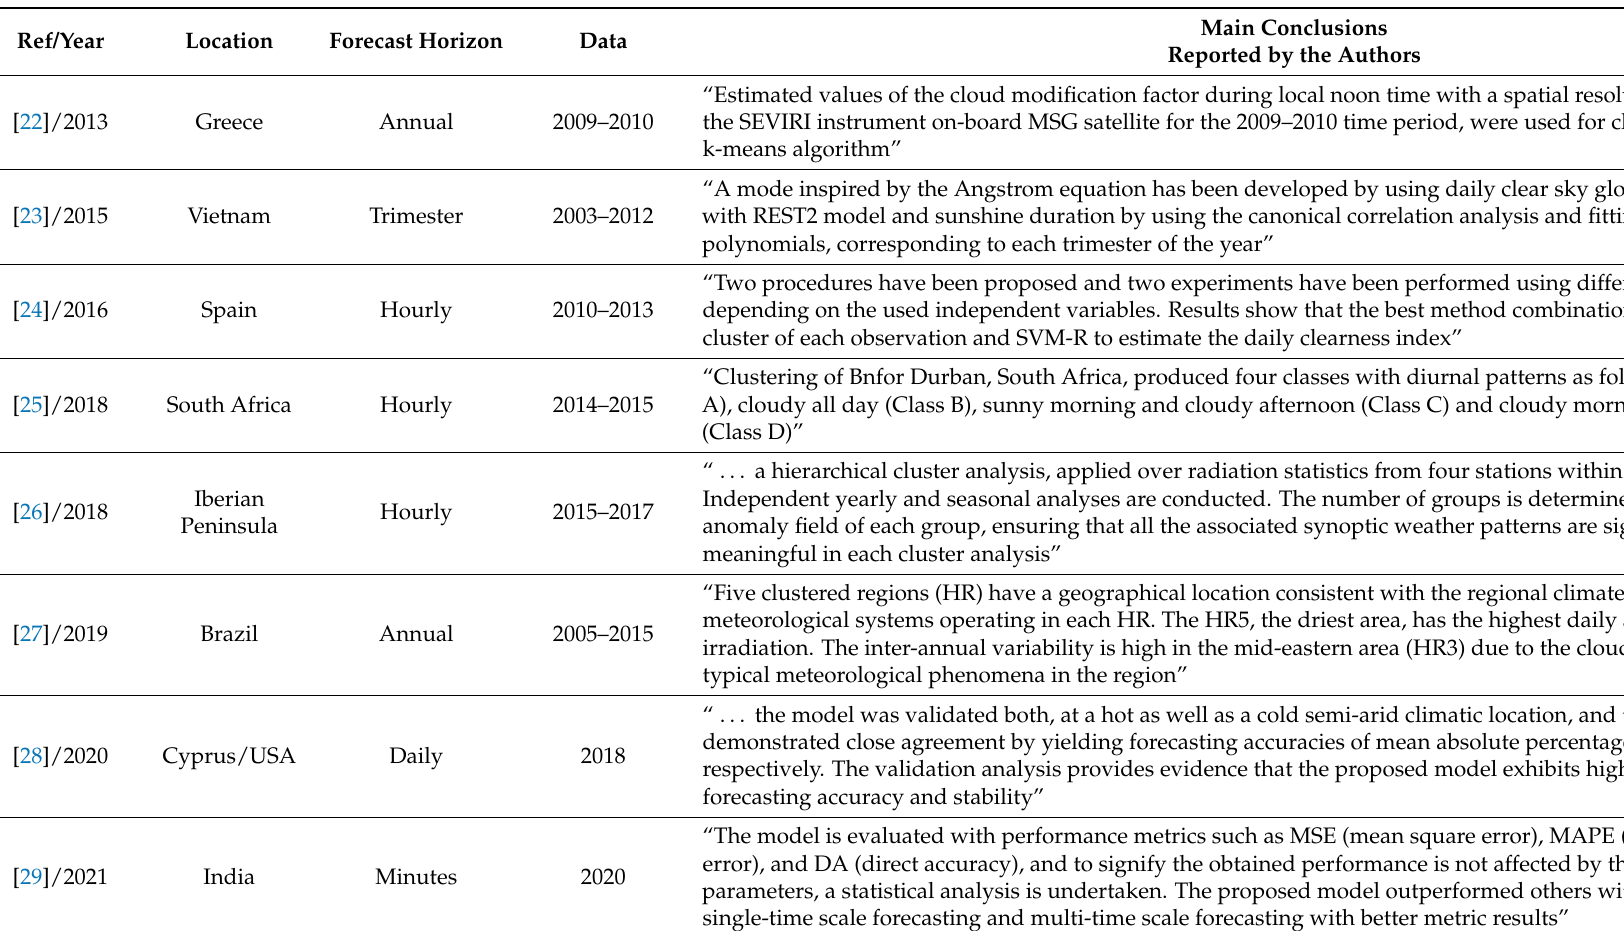
Table 2. Summary of the state of the art for the clustering model